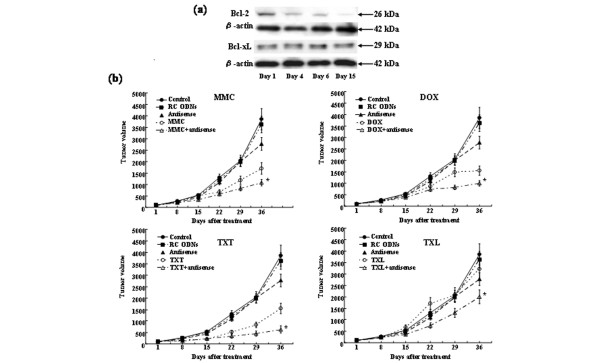
Effects of treatment with antisense Bcl-2 and mitomycin C, doxorubicin, paclitaxel, or docetaxel on BT-474 cells. (a) Expression levels of Bcl-2 and Bcl-xL protein in BT-474 cells transplanted into athymic mice after treatment with antisense (AS) Bcl-2 oligodeoxynucleotides (ODNs) were measured by Western blot analysis at the indicated time points. (b) Enhancement of the antitumor effects of anticancer drugs by AS Bcl-2 ODNs in BT-474 tumor xenografts. Each point represents the mean tumor volume of the eight mice in each group. Error bars indicate SD. *, P < 0.05, analysis of variance with Fisher's least significant difference test. The data presented are from two independent experiments. MMC, mitomycin C; DOX, doxorubicin; TXL, paclitaxel; TXT, docetaxel.